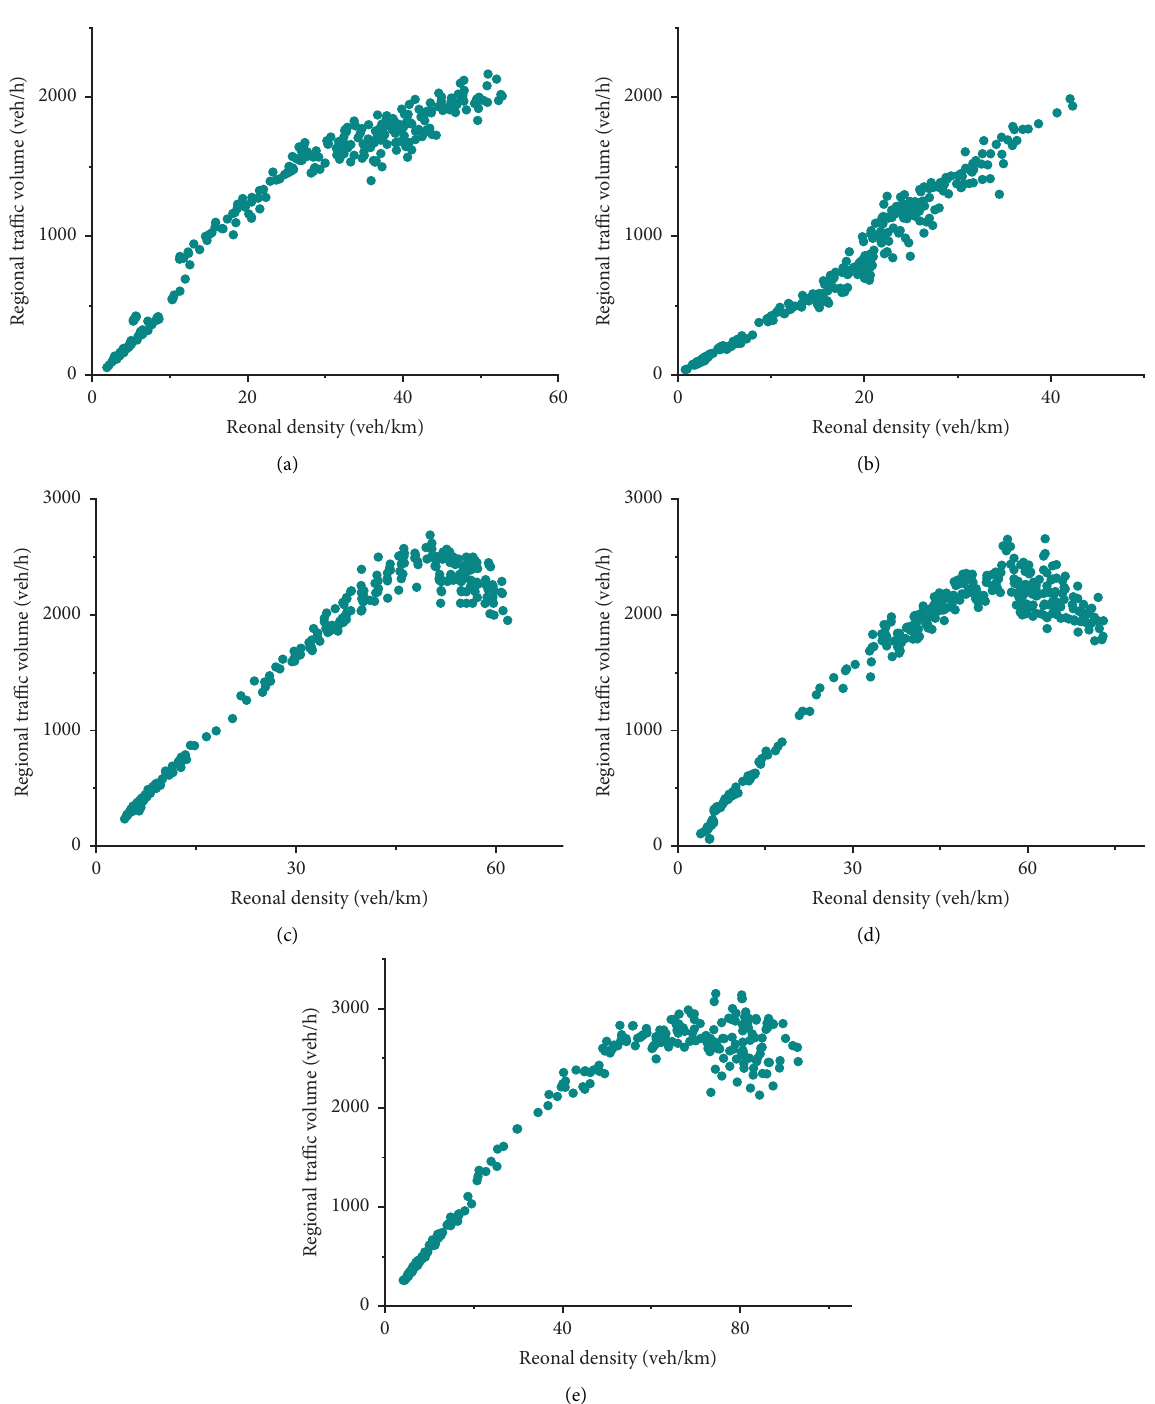
Figure 6: MFD of each subregional. (a) Subregional one. (b) Subregional two. (c) Subregional three. (d) Subregional four. (e) Subregional